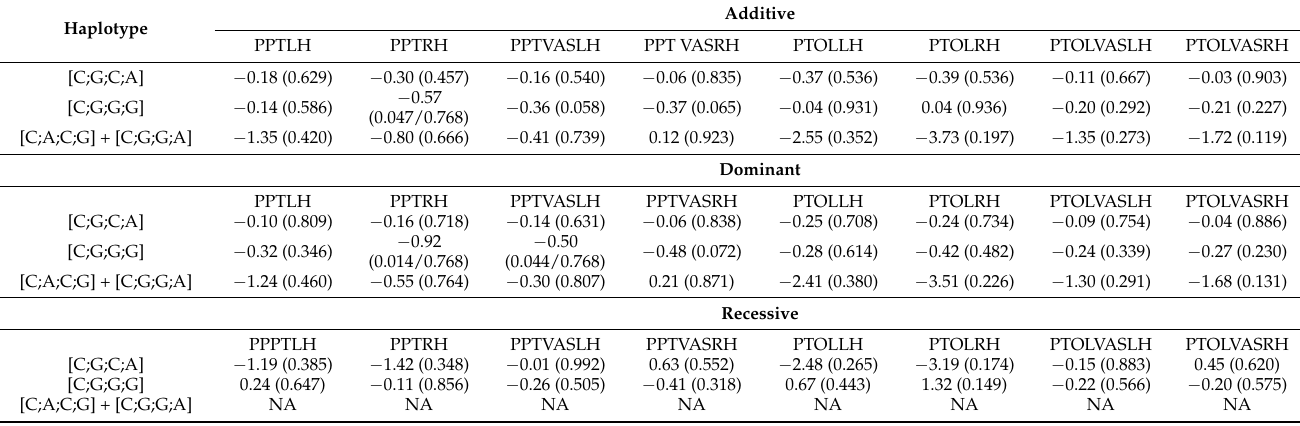
Table 4. Regression of pain thresholds/tolerance on catechol-O-methyltransferase ( COMT ) haplo- types assuming an additive, dominant or recessive effect (adjusted for age and